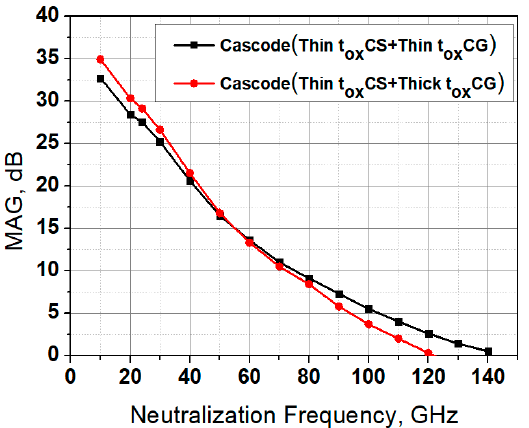
Figure 5. Simulated MAG according to neutralization frequency (thin-oxide FET CS + thin/thick-oxide FET CG). oxide FET CG).